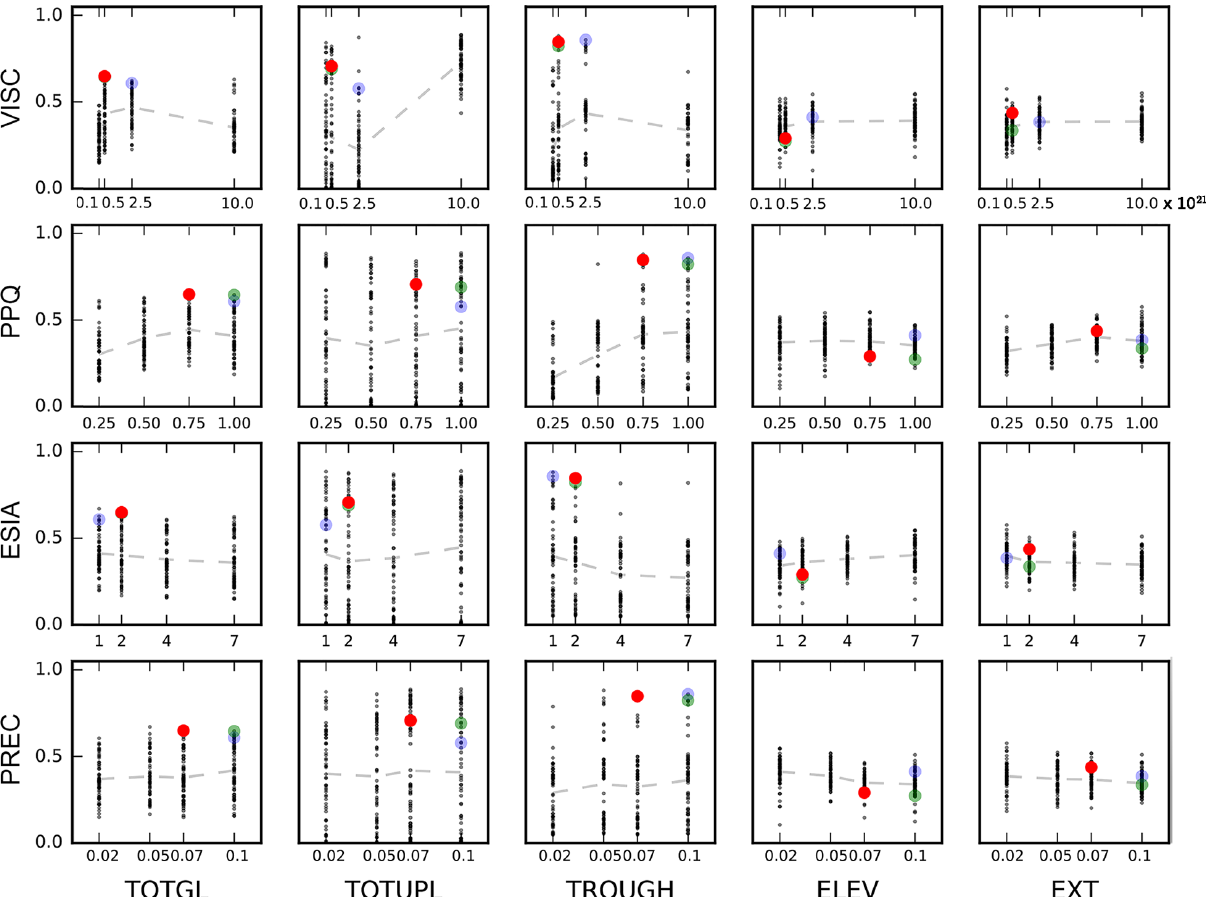
Figure 5. Scatter plots of five individual data-type scores (panels from left to right; see definition in Sect. 2.2) for each parameter setting (VISC, PPQ, ESIA and PREC on y axis). Red dots indicate the best-score member; green and blue dots indicate the second and third best ensemble members (see Table 1). Grey dashed line indicates mean score tendency over sampled parameter